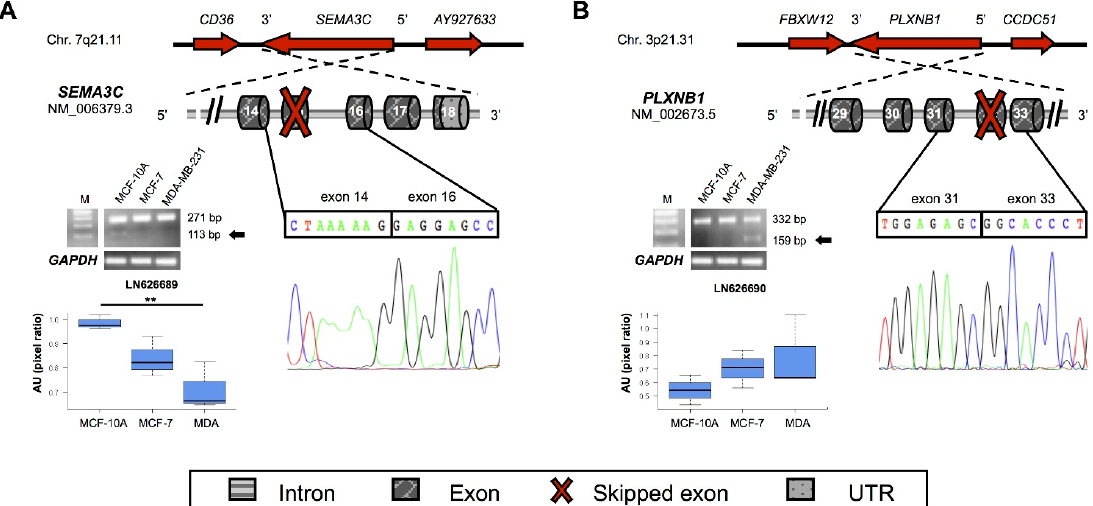
Figure 4. Schematic representation of de novo identified transcripts for ( A ) SEMA3C ( B ) PLXNB1 genes. Nucleotide sequenceand their expression by RT-PCR in breast cell lines are also depicted. Details about the gel bands and their quantification are provided in Figure 2’s legend. Asterisks indicate significant p values (** p < 0.01).